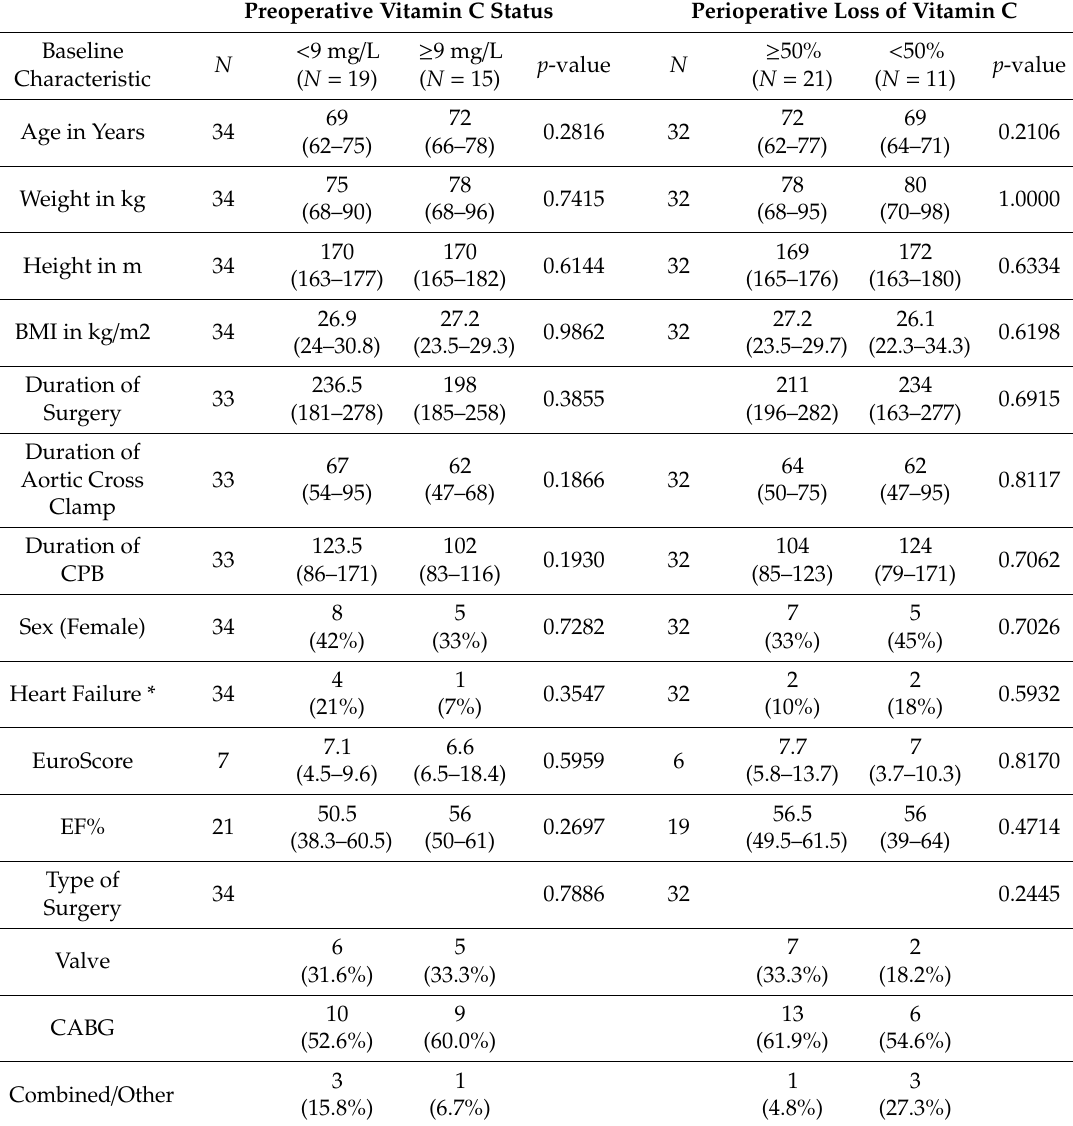
Table 1. Baseline characteristics of patients included in clinical analysis. BMI, body mass index; CPB, cardiopulmonary bypass; EuroScore, preoperative European System for Cardiac Operative Risk Evaluation Score; EF%, preoperative ejection fraction; CABG, coronary artery bypass graft; * clinical signs of heart failure as assessed by the New York Heart Association Score Class II–IV; N, number of patients, values presented as median [interquartile range] or amount